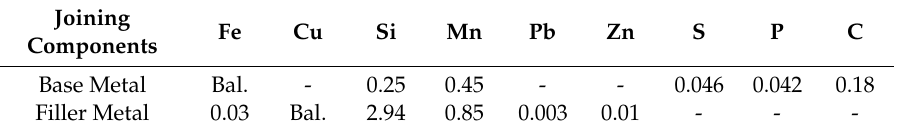
Table 1. The composition (in wt %) of the base metal and filler metal.